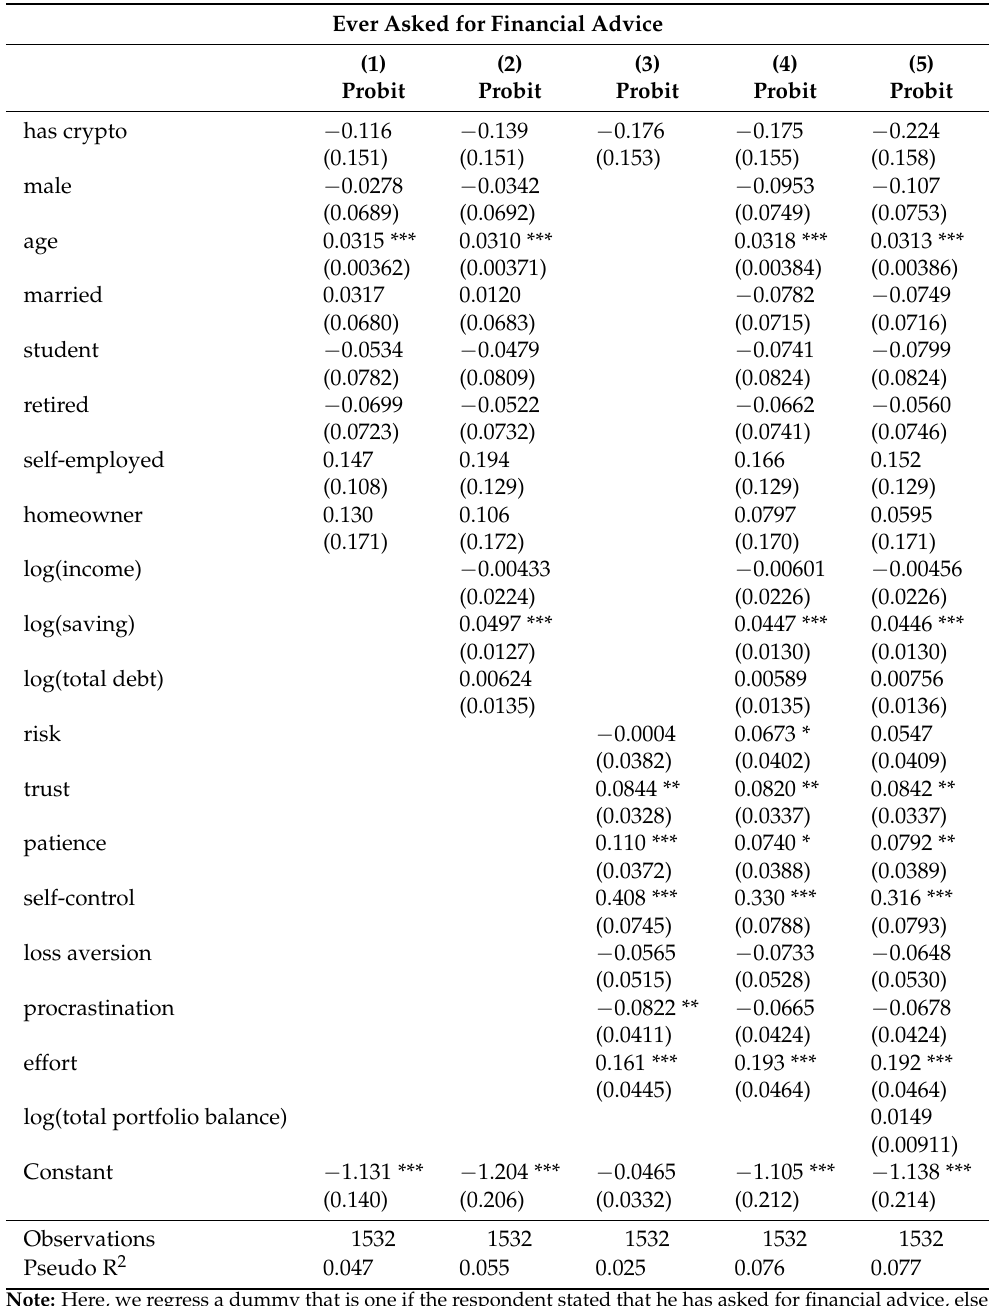
Table A8. Probit regression on financial advice ever received. Source: Own